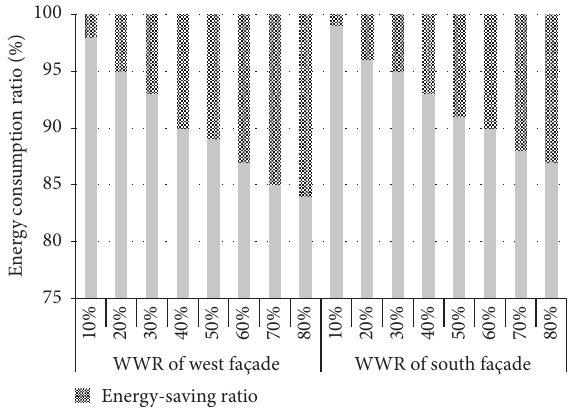
Figure 7: Energy consumption saving rate by installation of hori- zontal shading device (Case 1).